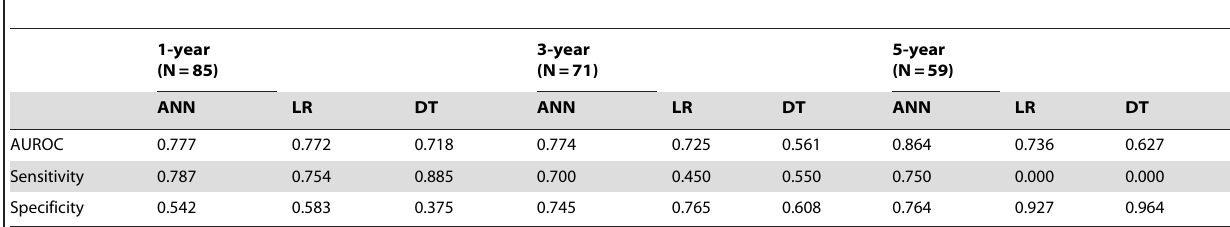
Table 4. Performance comparison of ANN, LR and DT models for predicting 1-, 3- and 5-year disease-free survival in validation